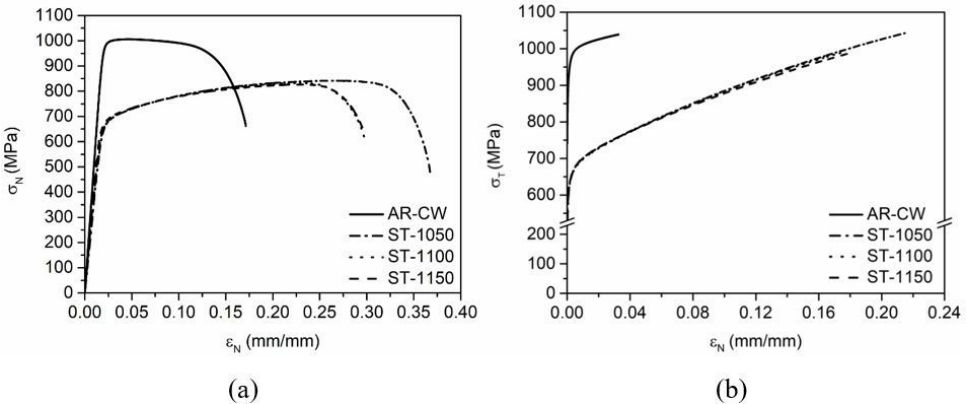
) versus nominal strain (ε N